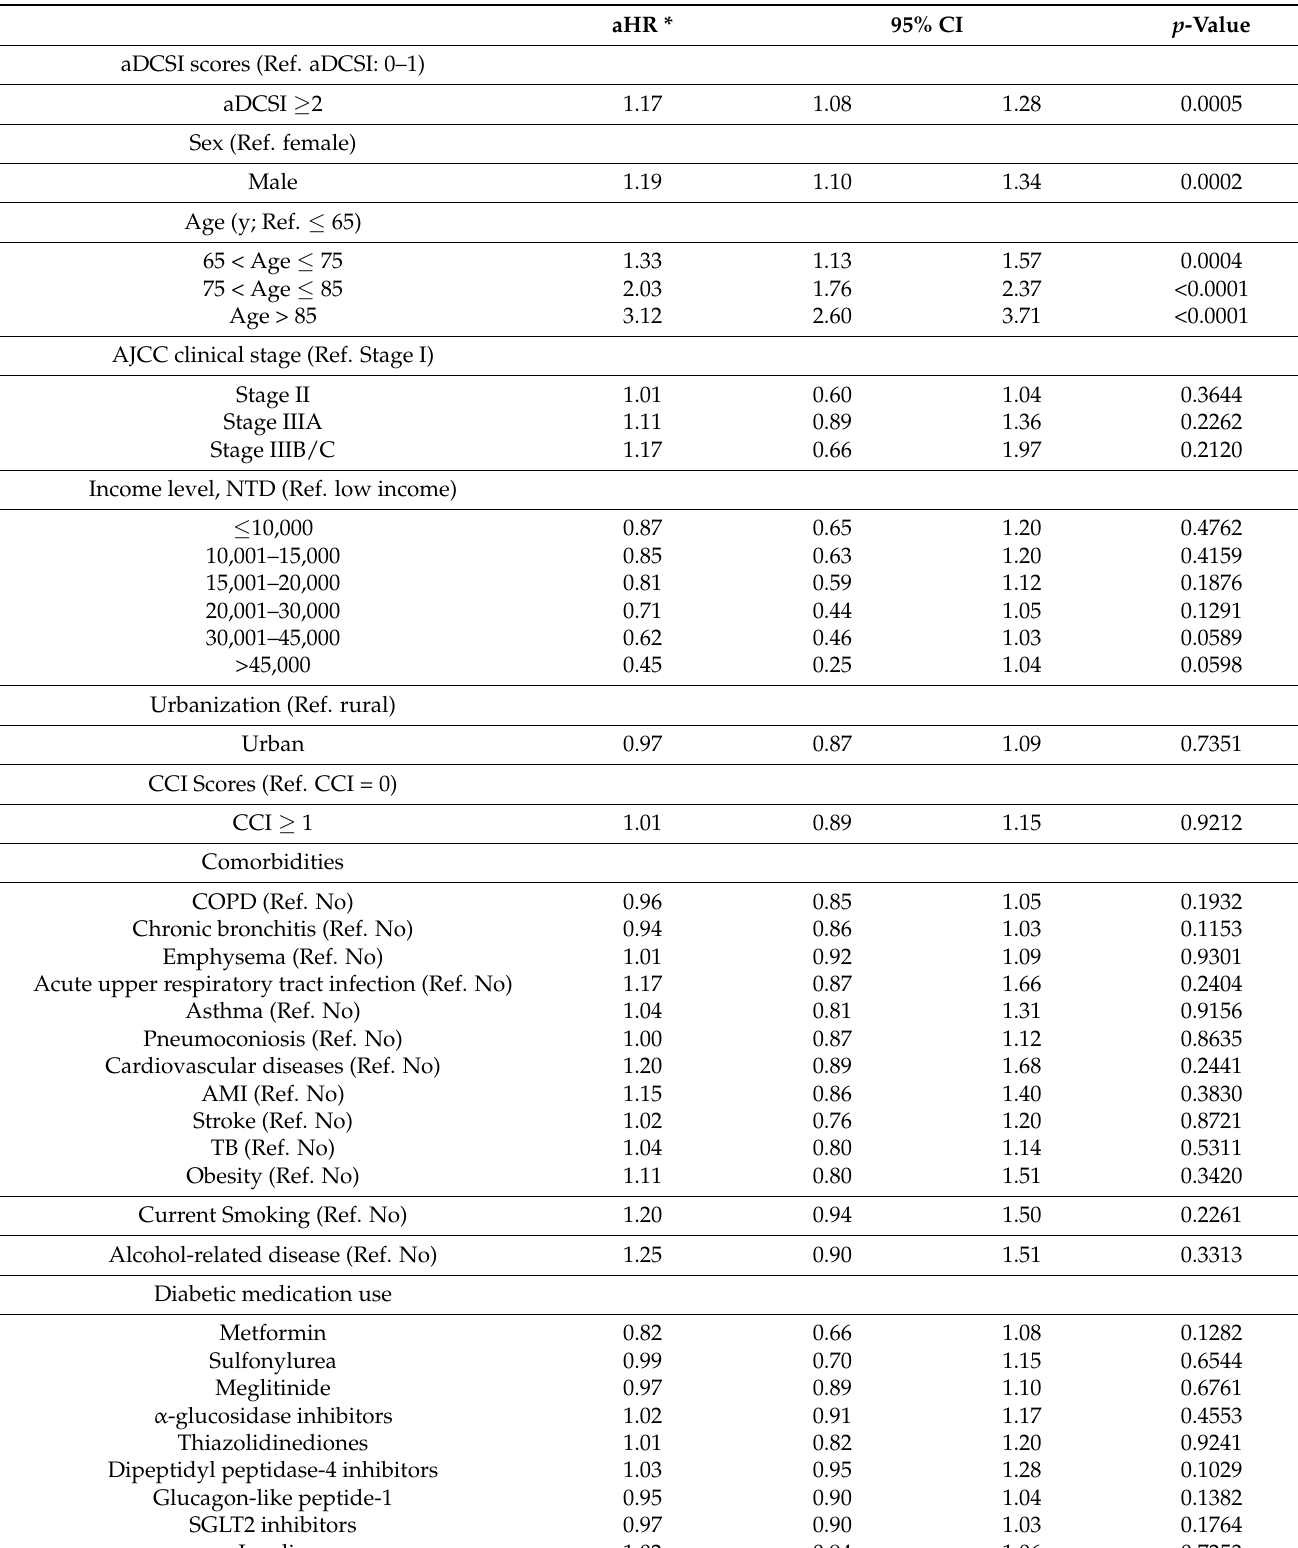
Table 2. Multivariable Cox proportional regression analysis of all-cause death among propen- sity score–matched patients with both lung squamous cell carcinoma and mild or moderate-to- severe diabetes. aHR